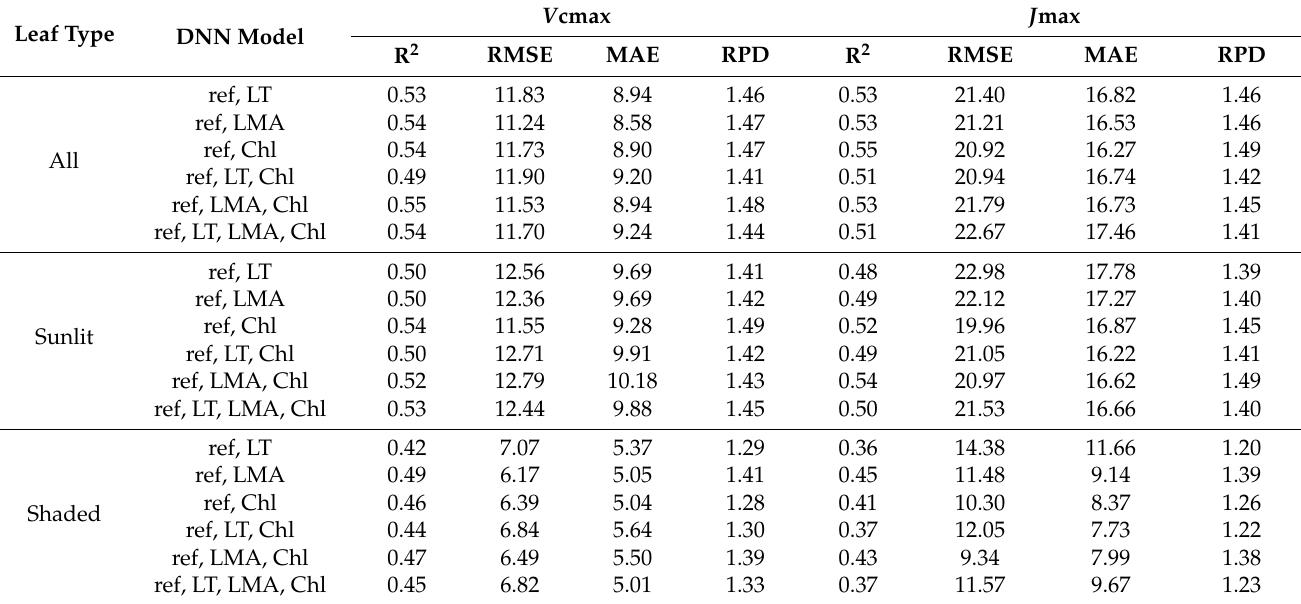
Table 2. Results of the DNN model for predicting photosynthetic traits ( V cmax: maximum carboxylation rate; J max: maxi- mum electron transport rate) using hyperspectral information, with different additional leaf traits and their combinations added in as predictors. R 2 : coefficient of determination; RMSE: root mean square error; MAE: mean absolute error; RPD: ratio of performance to standard